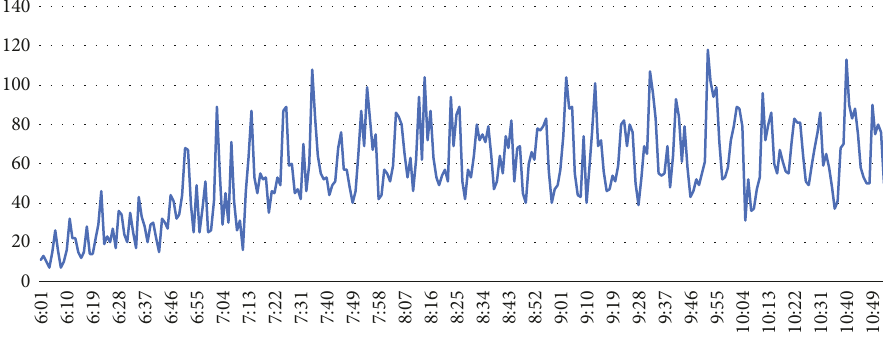
Figure 2: Passenger volumes of line S1 per minute in the study period.